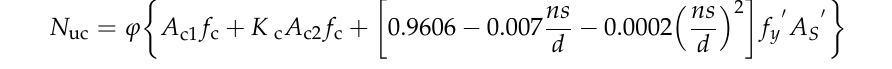
Table 5. Comparison between model results and experimental